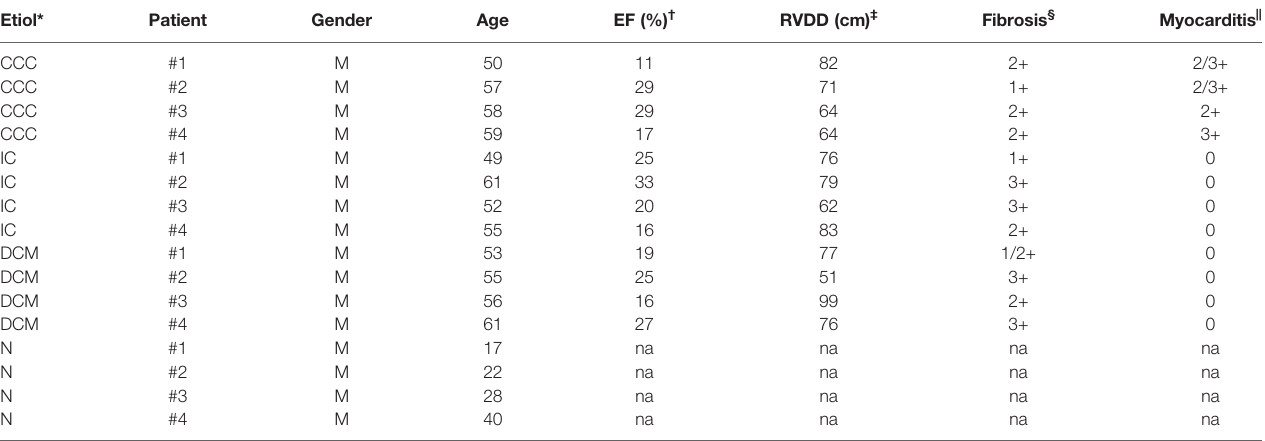
TABLE 1 | Baseline characteristics of patients included in the differential proteomic